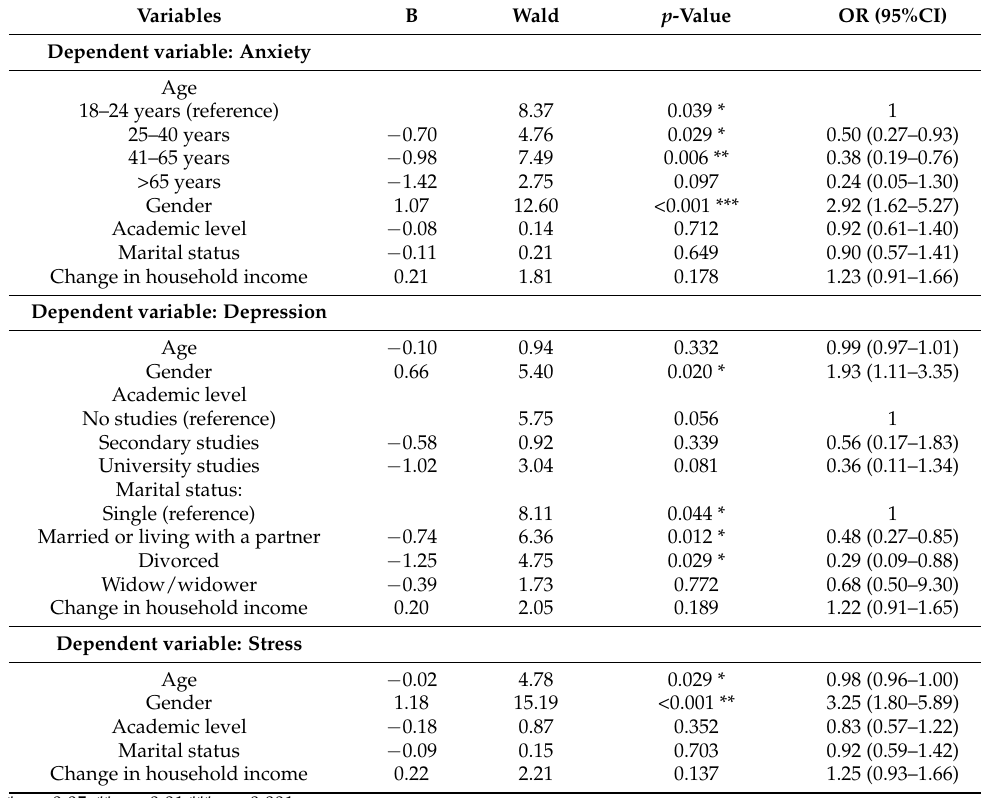
Table 3. Logistic regression analyses explaining mental